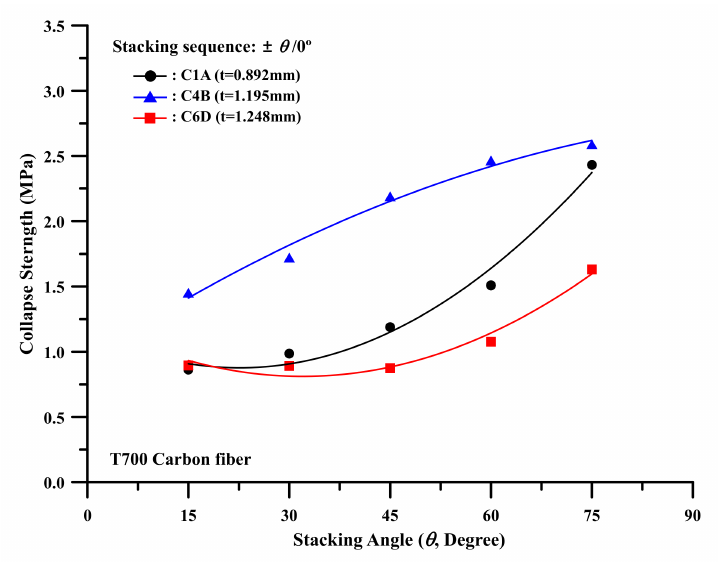
Figure 13. Dependence of collapse strength on stacking angle ( ± θ